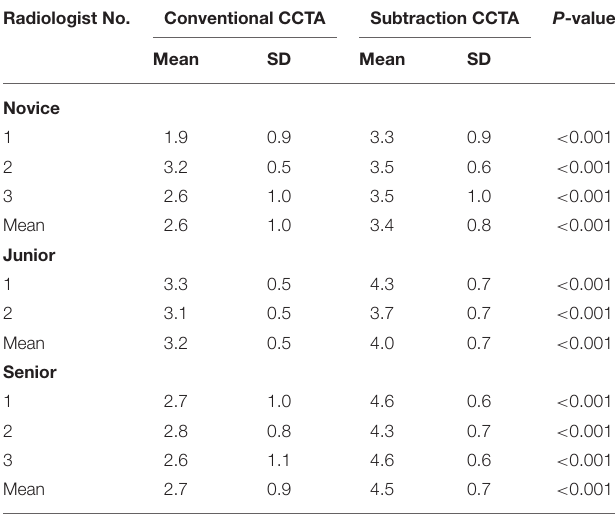
TABLE 2 | Diagnostic confidence for each radiologist with conventional or subtraction CCTA. Radiologist